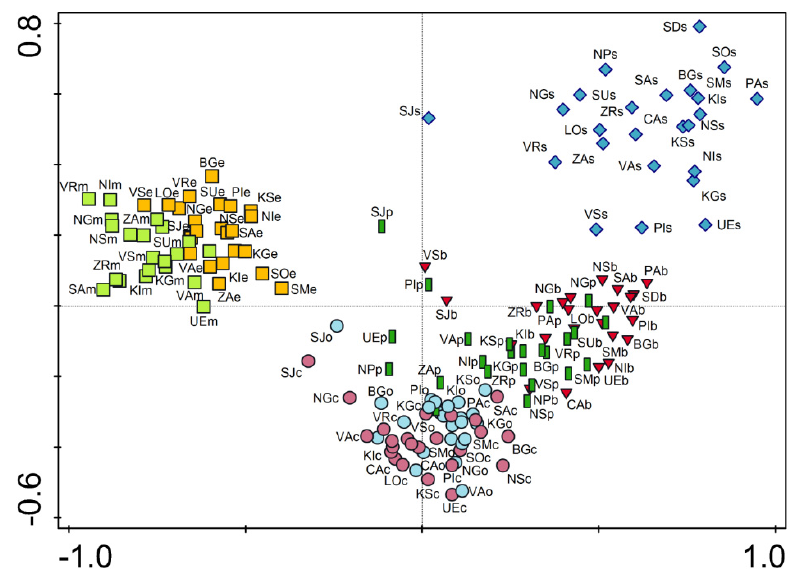
Figure 2. PCA ordination of plots according to plant species composition. Eigenvalues: axis 1, 0.2492; axis 2, 0.0925. Abbreviations: the first two uppercase letters represent the city code (see Table 2), the third lowercase letter represents the habitat type (see Material and Methods). Legend: red triangles—boulevards, orange squares—early successional sites, light green squares—mid-successional sites, dark green boxes—parks, purple circles—residential area (compact building pattern), light blue circles—residential area (open building pattern), blue diamonds—squares. Table 2. Characterization of the studied cities in Serbia .